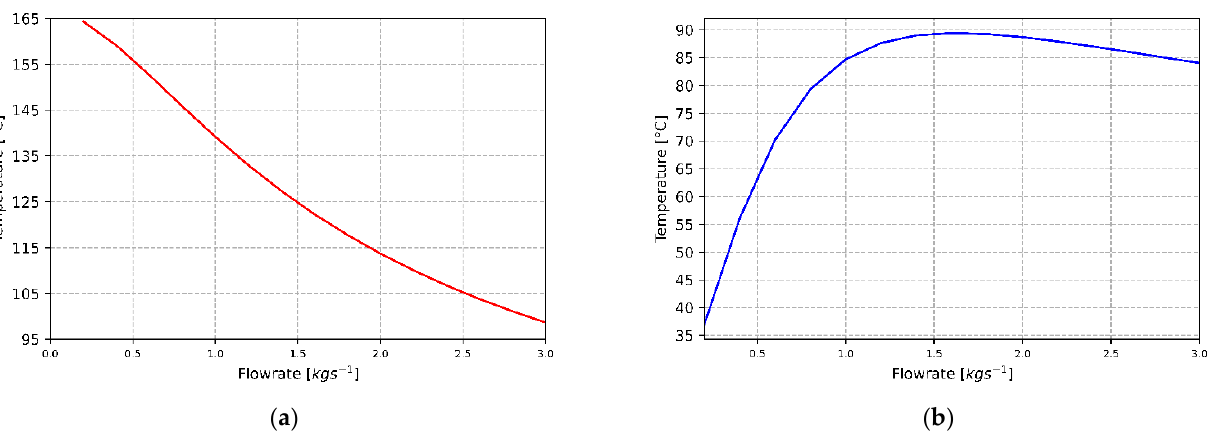
Figure 8. Wellhead temperature as the flow rate value changes: ( a ) Coaxial WBHE; ( b ) U-tube WBHE.